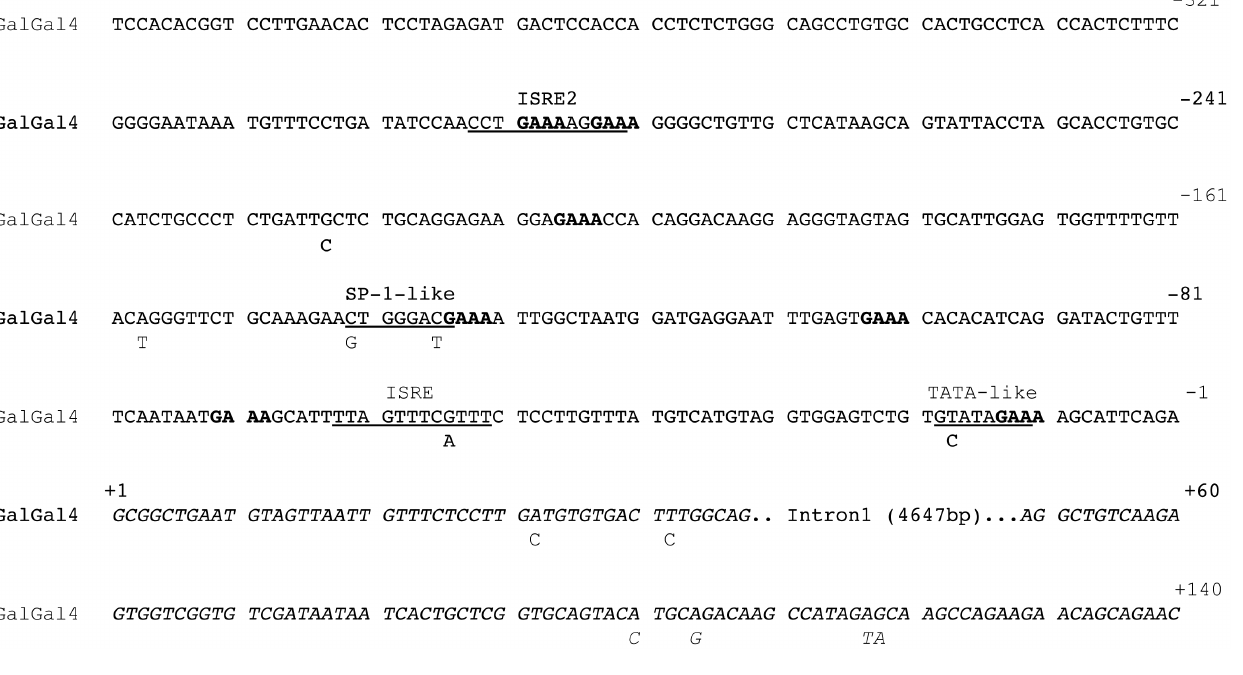
Figure 1. Location of SNP within the promoter and untranslated region of chicken Mx. galGal4 Mx promoter region starting 400 nt upstream of the RNA transcription initiation site through the first 140 nt of the RNA transcript (excluding 4,647 nt from intron 1) are shown above. The previously described ISRE ( 2 52 to 2 63) as well as other potential functional elements (ISRE2, 2 282 to 2 293; SP1-like element, 2 135 to 2 142; TATA box-like element, 2 19 to 2 12) are underlined. The ‘‘GAAA’’ motif found repeated in many IFN regulated gene promoter regions are shown in bold. SNP found in the 9 elite lines that differ from galGal4 are shown under the reference sequence. Additionally, the RNA transcription initiation and Mx 5 9 UTR, comprised of exon 1 and the first 92 nt of exon 2, is shown in